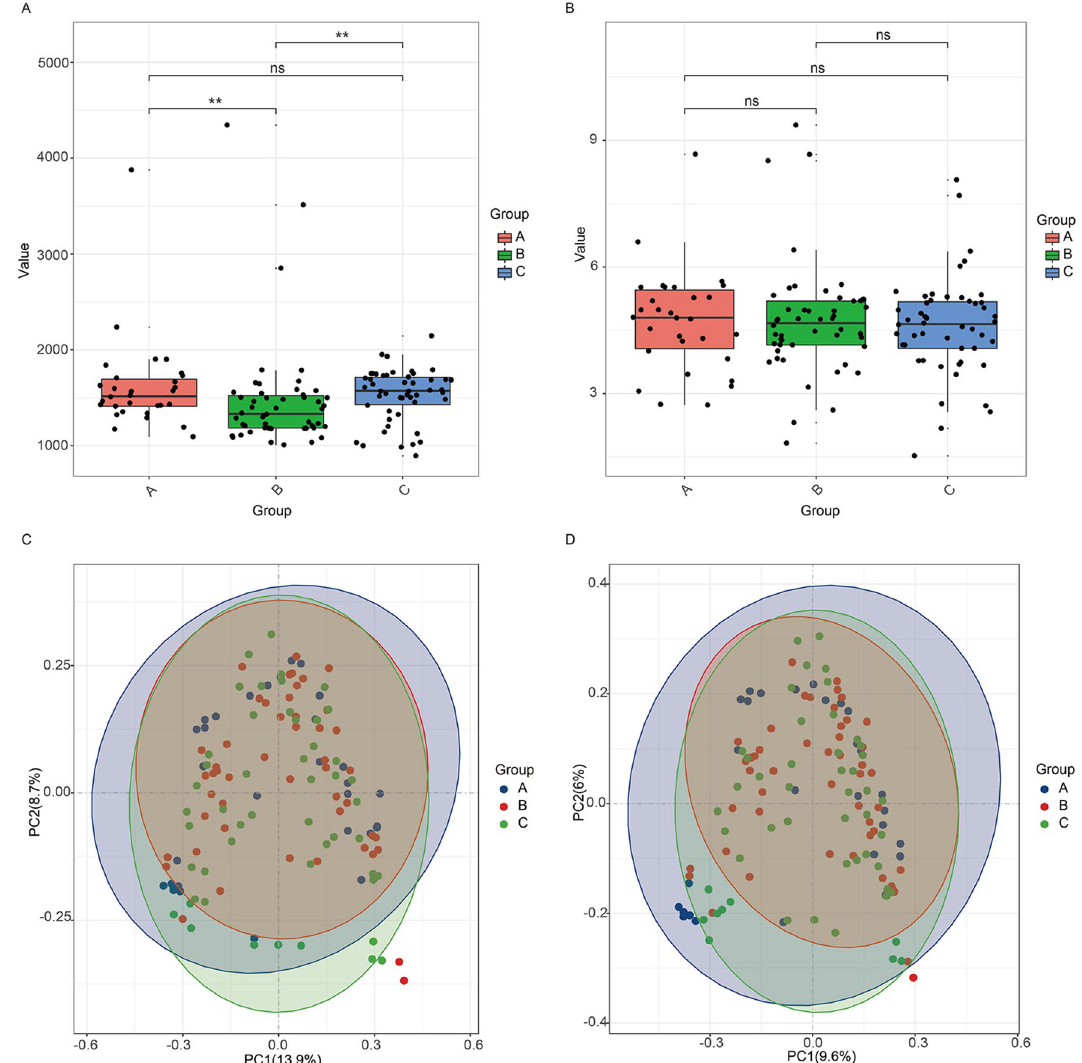
Figure 2. α- and β-diversity showing the overall comparison of the microbiota. (a) Chao index and (b) Shannon index in healthy child ( A , n = 30), child with nonwheezing MPP ( B , n = 50), and child with wheezing MPP ( C , n = 50). PCoA plots based on (c) Bray–Curtis and (d) Binary-Jaccard dissimilarities showing the clustering of the bacterial community compositions for healthy child, child with nonwheezing MPP, and child with wheezing MPP. One-way ANOVA test was used for a and b. ** P < 0.01. ns, not